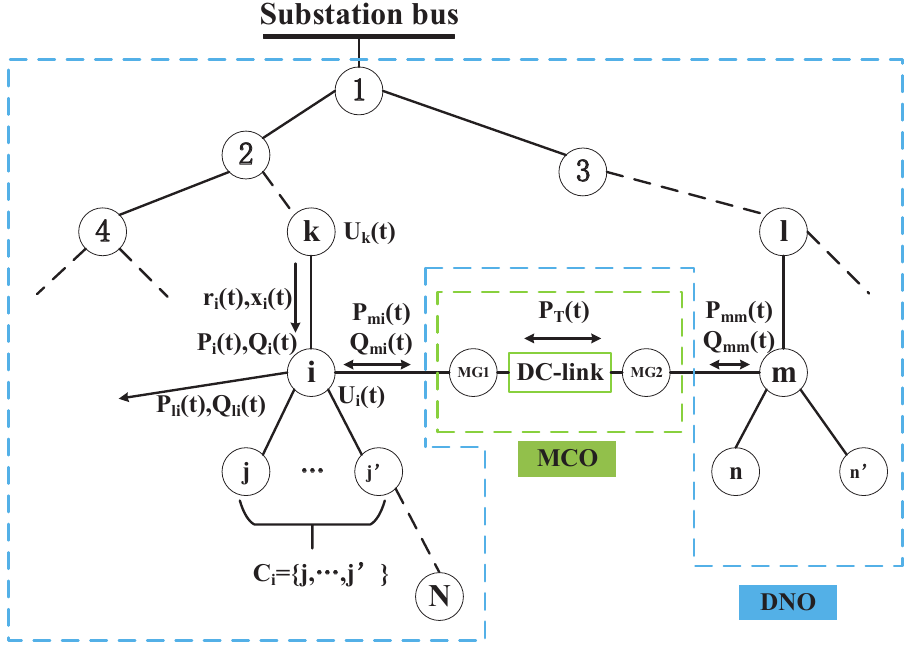
Figure 2. Distribution network with Direct Current (DC)-linked Microgrids